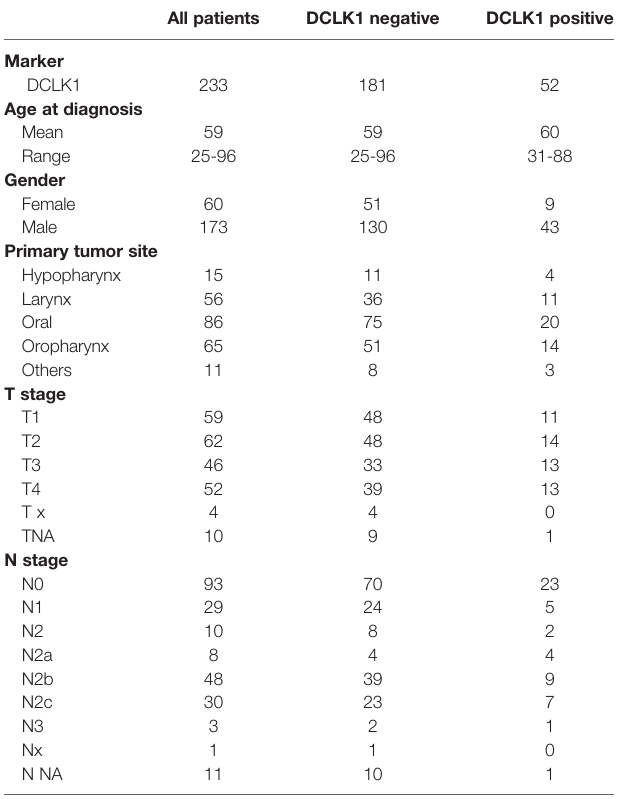
TABLE 1 | Demographic and clinical characteristics of patients with primary HNSCC. All patients